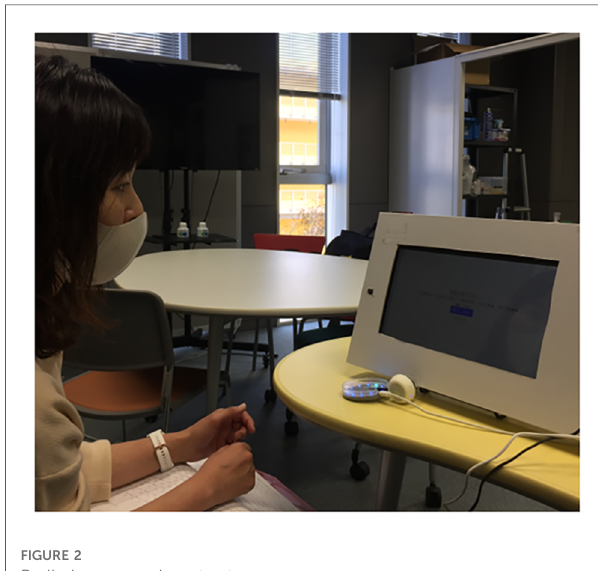
FIGURE 2 Preliminary experiment setup.